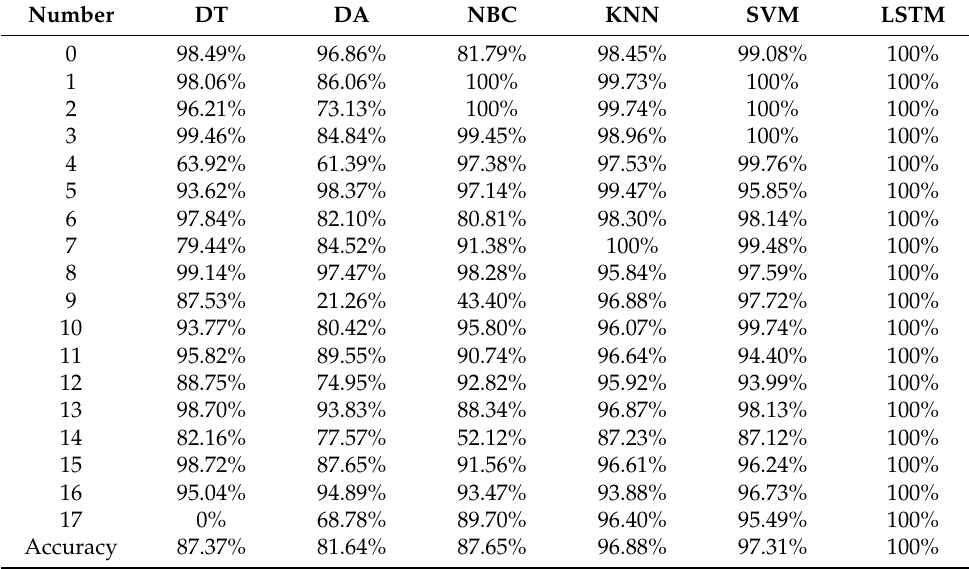
Table 5. Accuracy of different